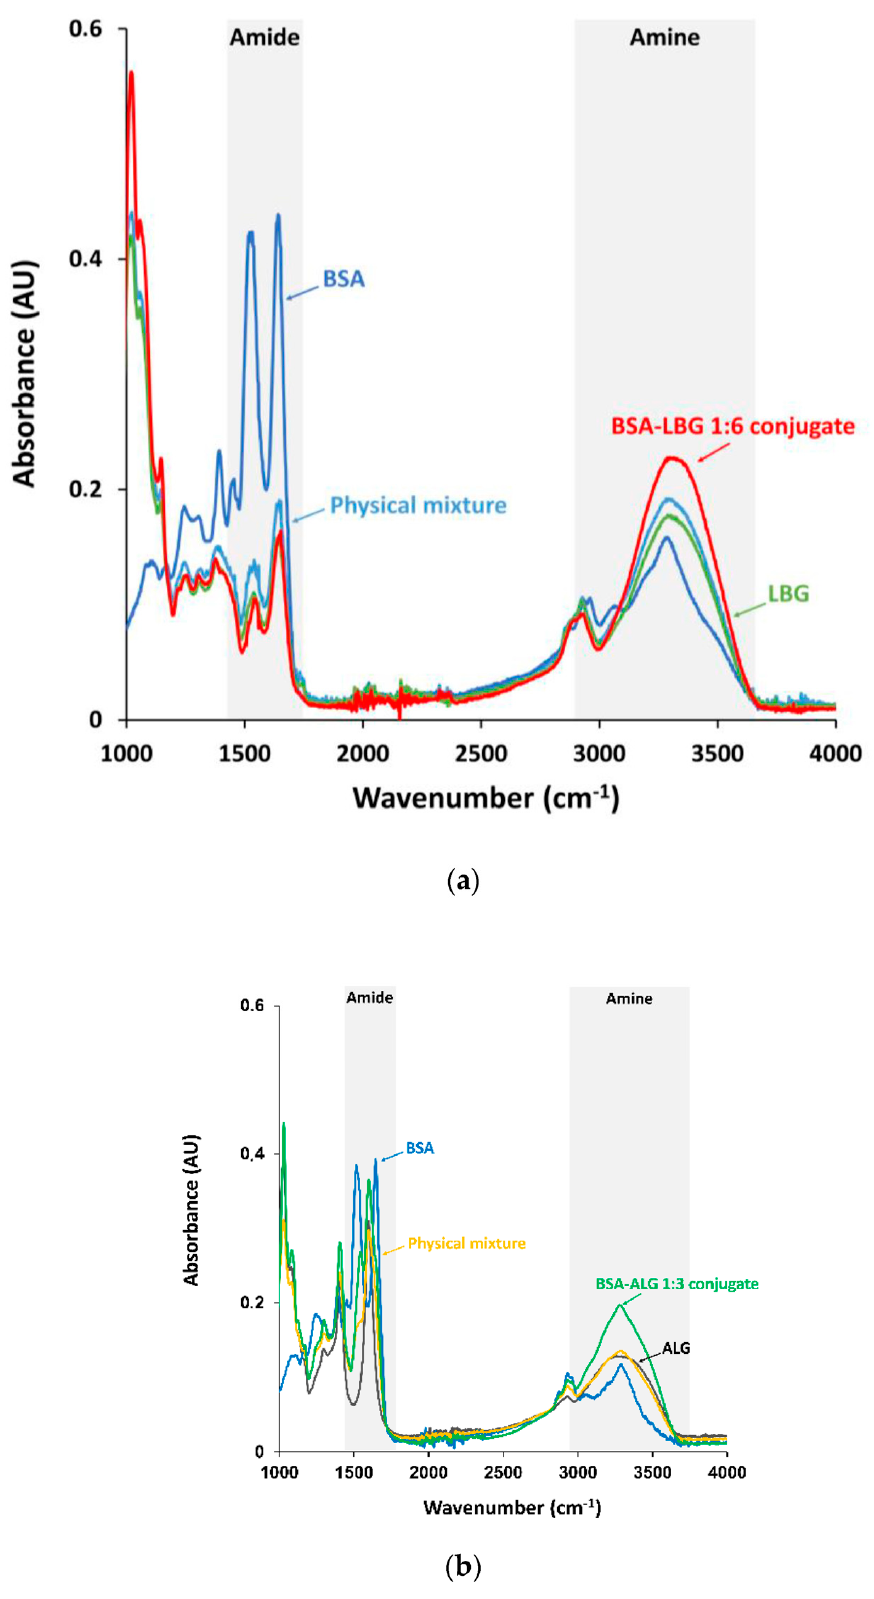
Figure 1. ( a ) FTIR absorption spectra of the native BSA, LBG, BSA–LBG physical mixture and BSA– LBG 1:6 conjugate; ( b ) FTIR absorption spectra of the native BSA, ALG, BSA–ALG physical mixture, and BSA–ALG 1:3